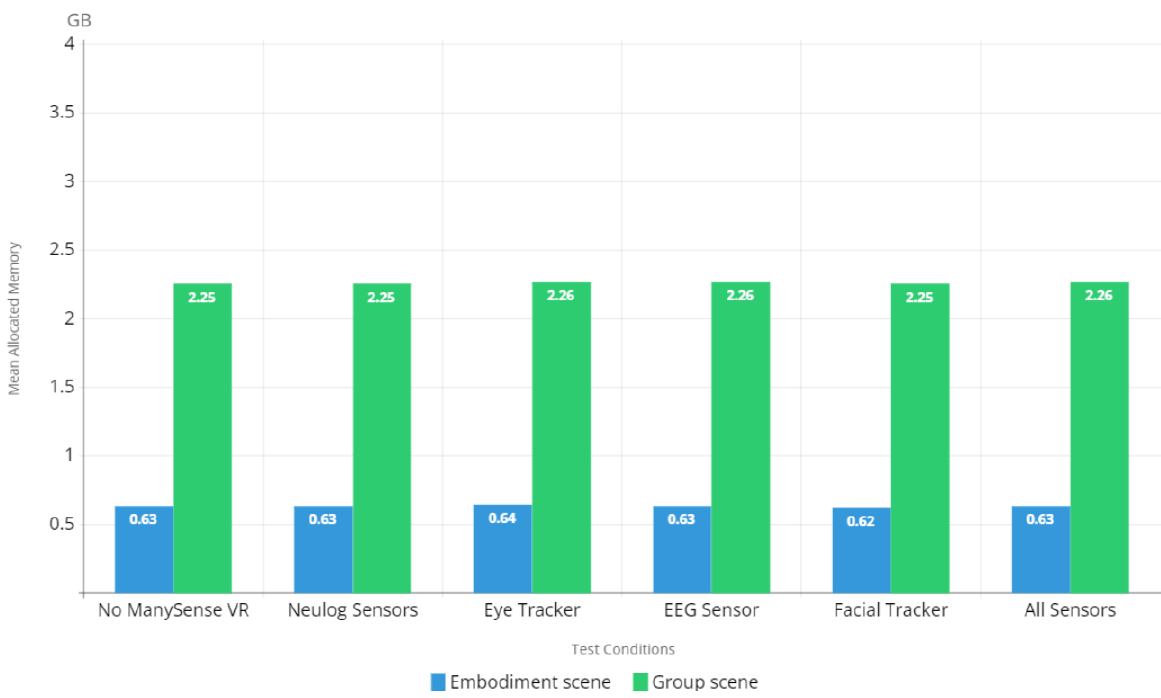
Figure 13. Mean allocated memory (GB) for each test condition and